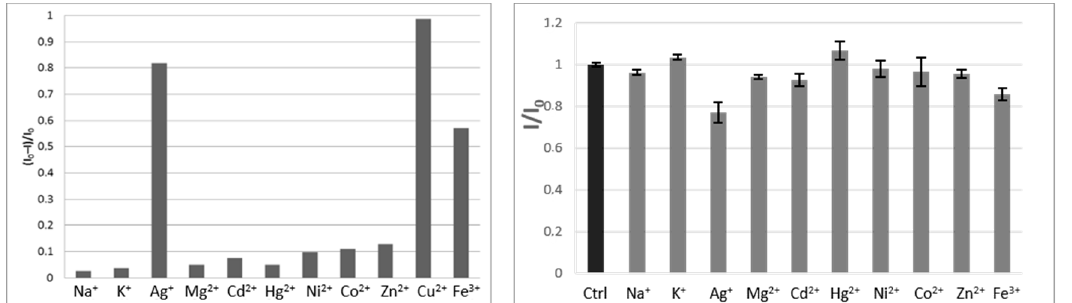
Figure 8. ( Left ) Comparison of the fluorescence intensity of compound 1 (1.72 × 10 − 5 M) with the studied metal ions (30 µ M). ( Right ) Selectivity of compound 1 towards the studied cations. The concentration of Cu 2 + was 1.4 µ M; the concentration of the other metal ions was 40 µ M. I 0 and I are the fluorescence intensities of the mixtures of compound 1 and Cu 2 + ions in the absence (Ctrl) and presence of other metals, respectively. Error bars represent standard deviations, as means of three experiments.